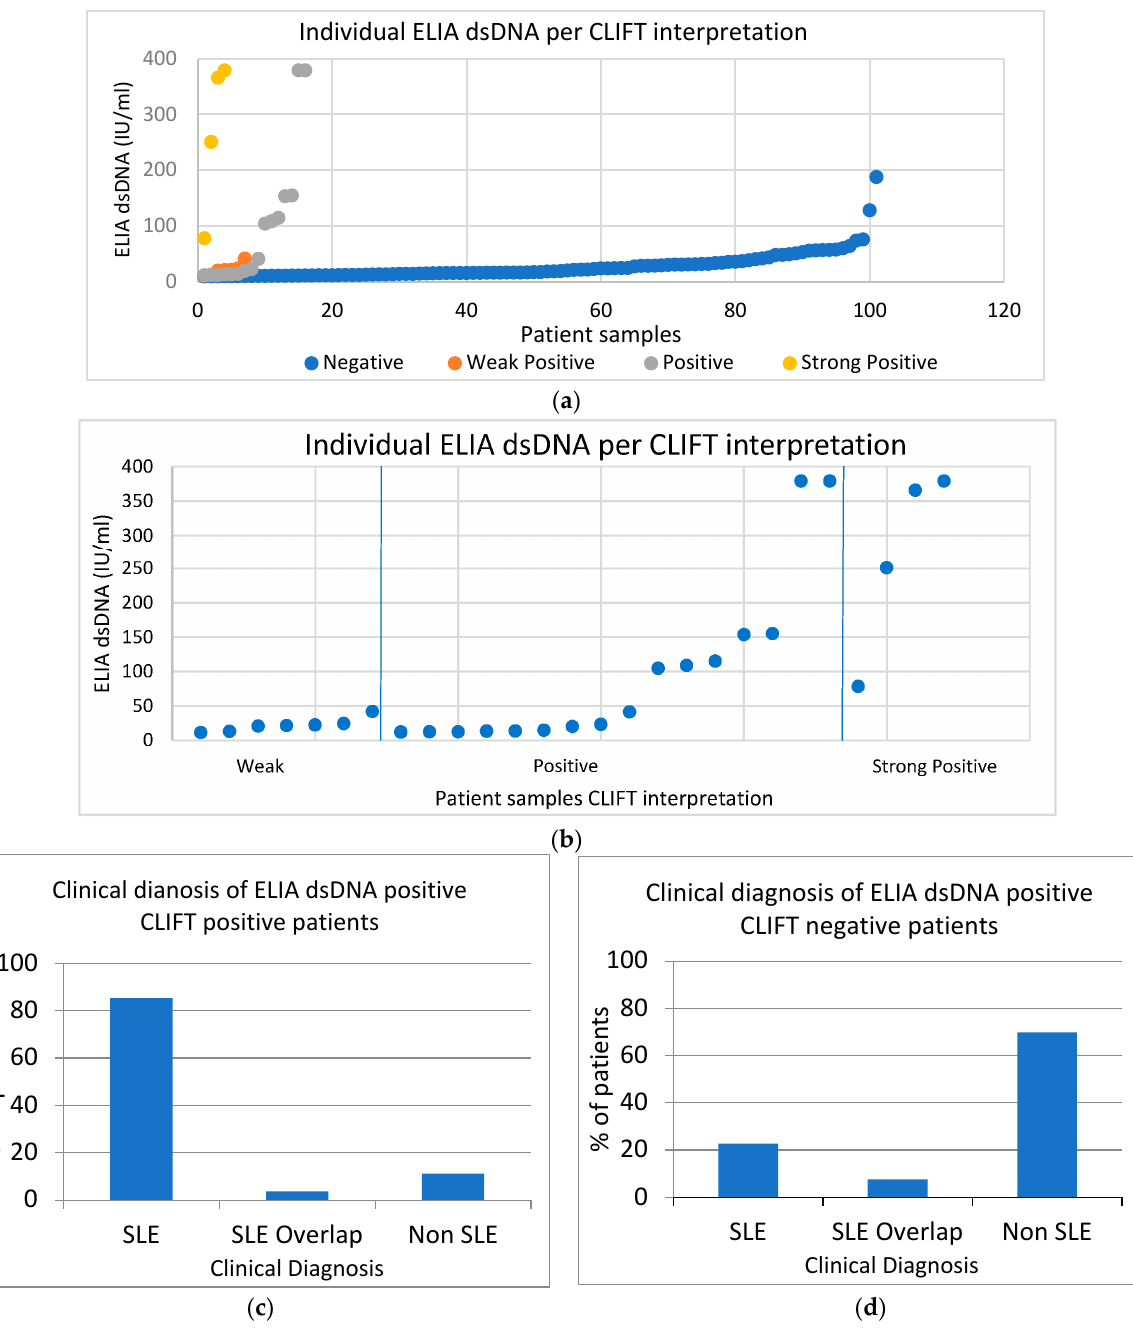
Figure 7. Relationship between quantitative ELIA dsDNA and CLIFT interpretations. ( a ) All ELIA dsDNA values of individual samples grouped into their CLIFT interpretation groups. Groups consist of negative (blue circle), weak positive (orange circle), positive (grey circle) and strong positive (yellow circle). ( b ) Separations of weak positive, positive and strong positive CLIFT interpretations. Trend of ELIA dsDNA value increases as interpretation increases from weak positive to strong positive. ( c ) Clinical diagnosis of patients with positive anti-dsDNA antibody results by ELIA and confirmed positive by CLIFT. A total of 85% of patients had an SLE diagnosis. A total of 4% had an SLE overlap syndrome. A total of 11% of patients had other diagnoses, excluding SLE. ( d ) Clinical diagnosis of patients positive for anti-dsDNA antibodies by ELIA but negative by CLIFT. A total of 23% of patients had an SLE diagnosis. A total of 7.5% of patients had SLE overlap syndromes. A total of 70% of patients did not have an SLE